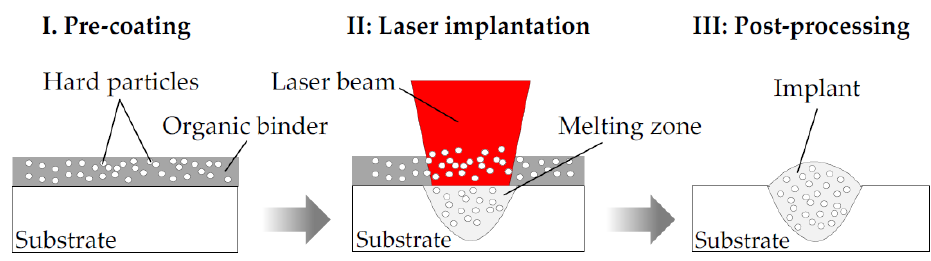
Figure 1. Schematic representation of the laser implantation process according to [16].